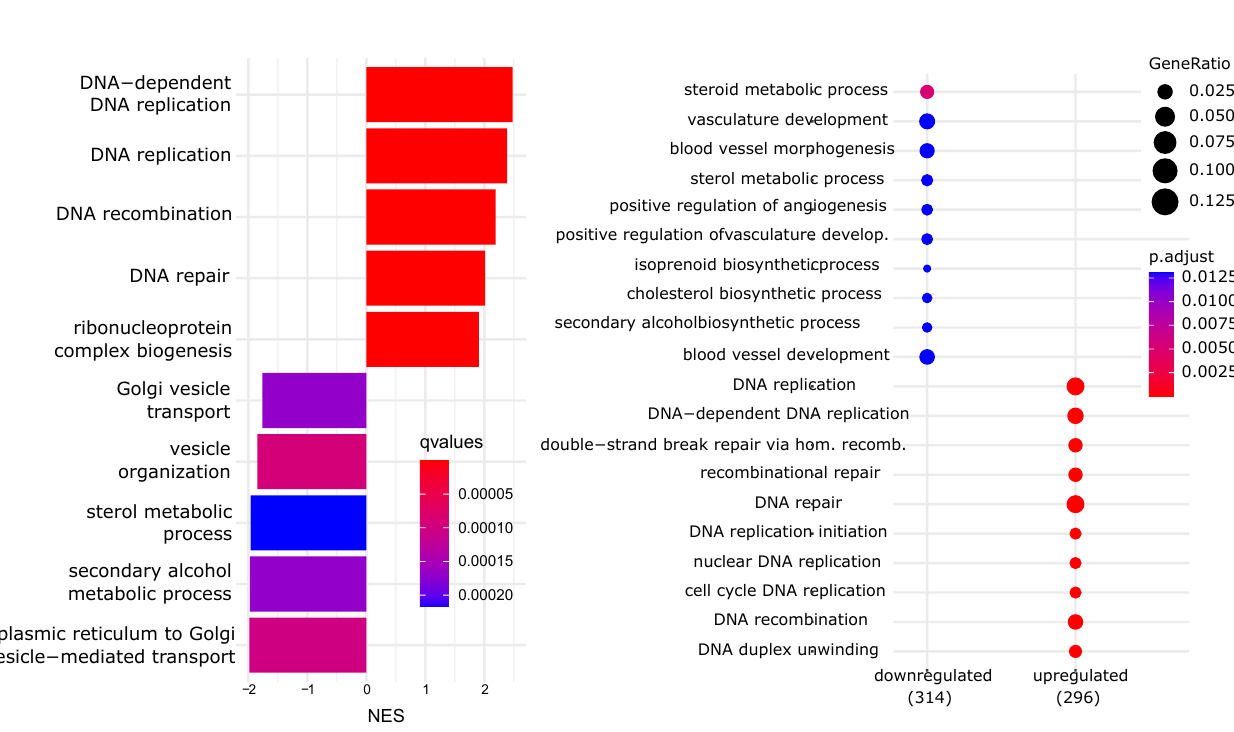
Figure 4. Antiandrogen treatment of VCaP cells upregulates DNA replication and reduces ER-Golgi transport processes. ( A ) Gene set enrichment analysis of VCaP cells treated with enzalutamide (GEO database, GSE62473): normalized enrichment scores (NES) of the most significant biological processes (Gene Ontology-BP) are shown. ( B ) Overrepresentation analysis (ORA) of VCaP cells treated with enzalutamide as before: most significant GO/biological